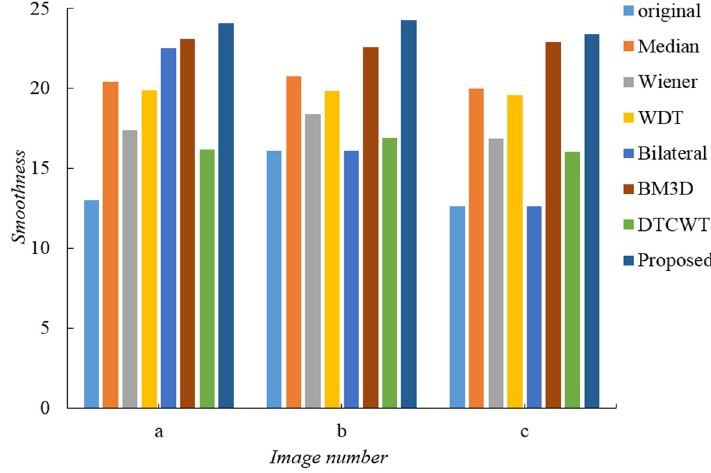
Figure 23. Smoothness of images using different methods.